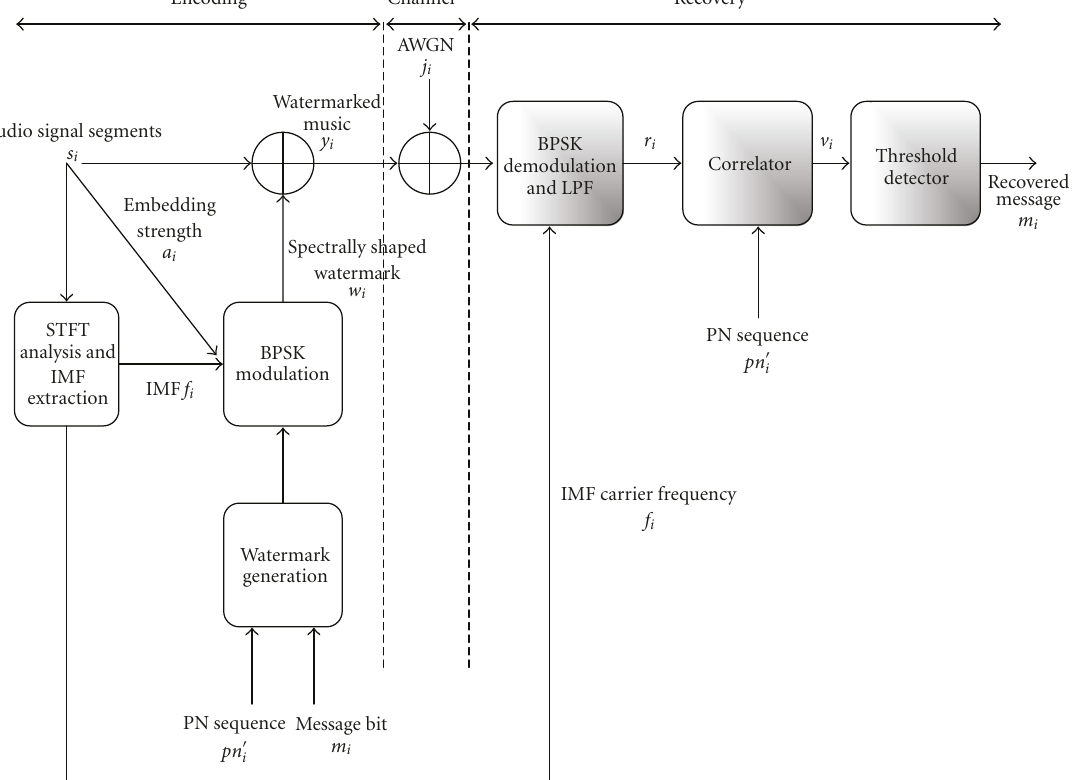
Figure 17: Watermark embedding and recovery using